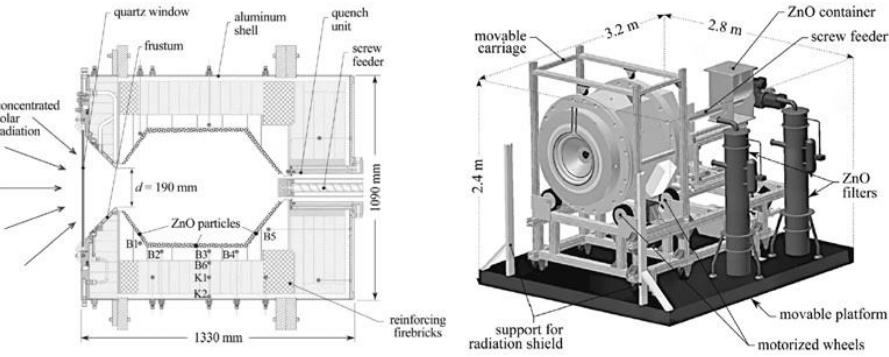
Figure 9. Scheme of 100 kW (thermal) prototype solar reactor for ZnO thermal dissociation.